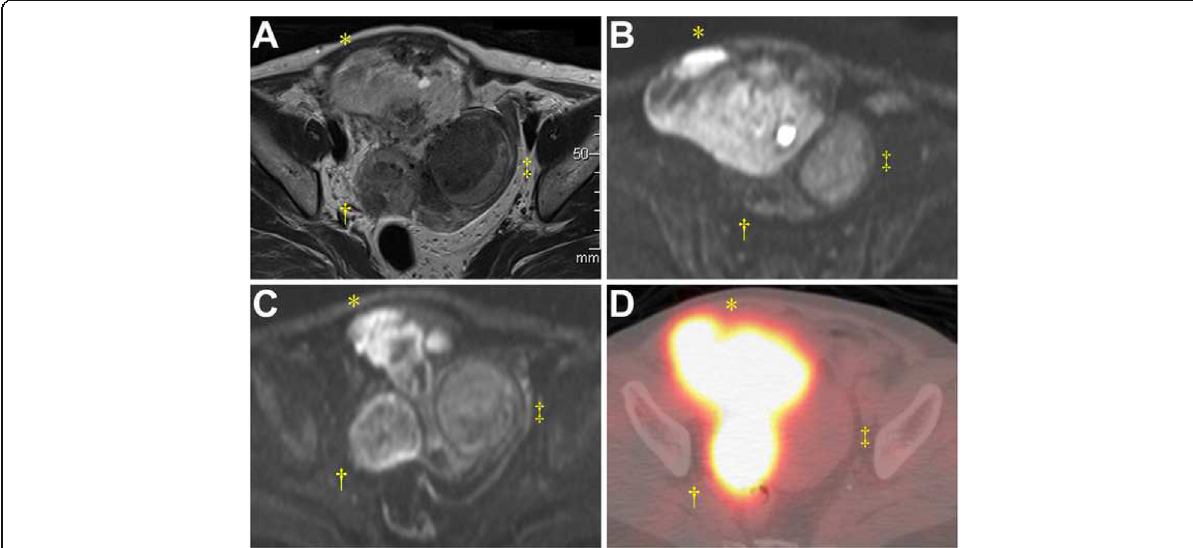
Fig. 1 Imaging of the uterine tumor composed of three components. a Pelvic axial T2-weighted magnetic resonance imaging disclosing a mass with heterogenous, mixed low and high intensity (*) and another mass with mostly low intensity ( † ) attached to the right-anterior and right- posterior serosa, respectively, and the remaining low-intensity intramural mass in the fundus ( ‡ ). b and c Diffusion-weighted images showing high intensity in the right-anterior tumor (*) and slightly high intensity in the right-posterior ( † ) and the fundal ( ‡ ) tumors ( d ) Positron emission tomography/computed tomography fusion image demonstrating high 18 F-fluorodeoxyglucose uptake of the right-anterior and right-posterior tumors (*, † ) in contrast to no uptake of the fundal tumor ( ‡